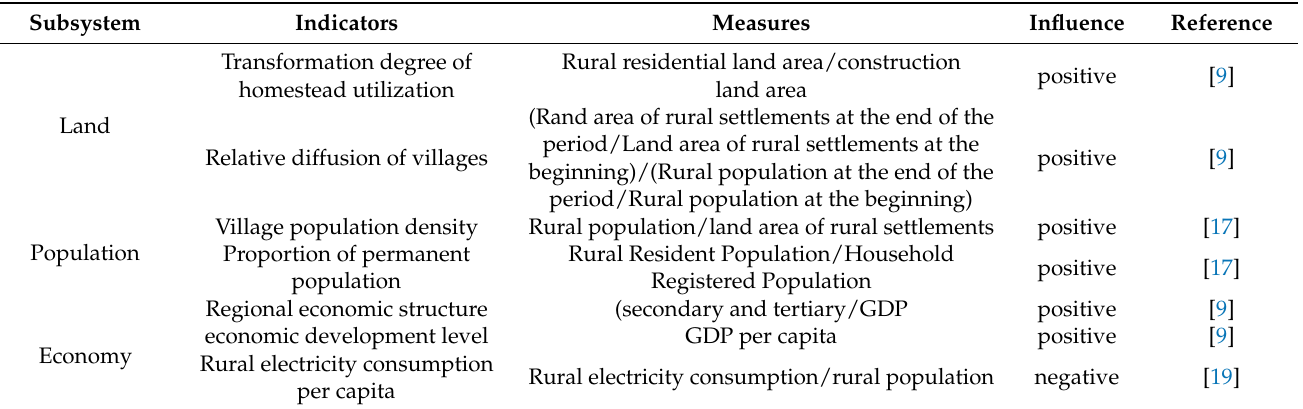
Table 2. Evaluation index system of rural hollowing degree at county scale in Sichuan